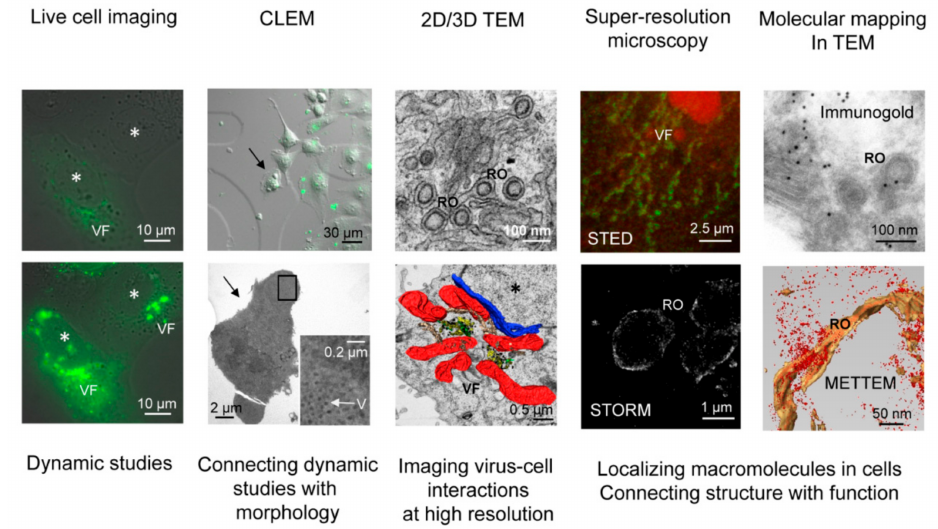
Figure 1. Visual introduction to imaging virus–host interactions. Images were obtained by